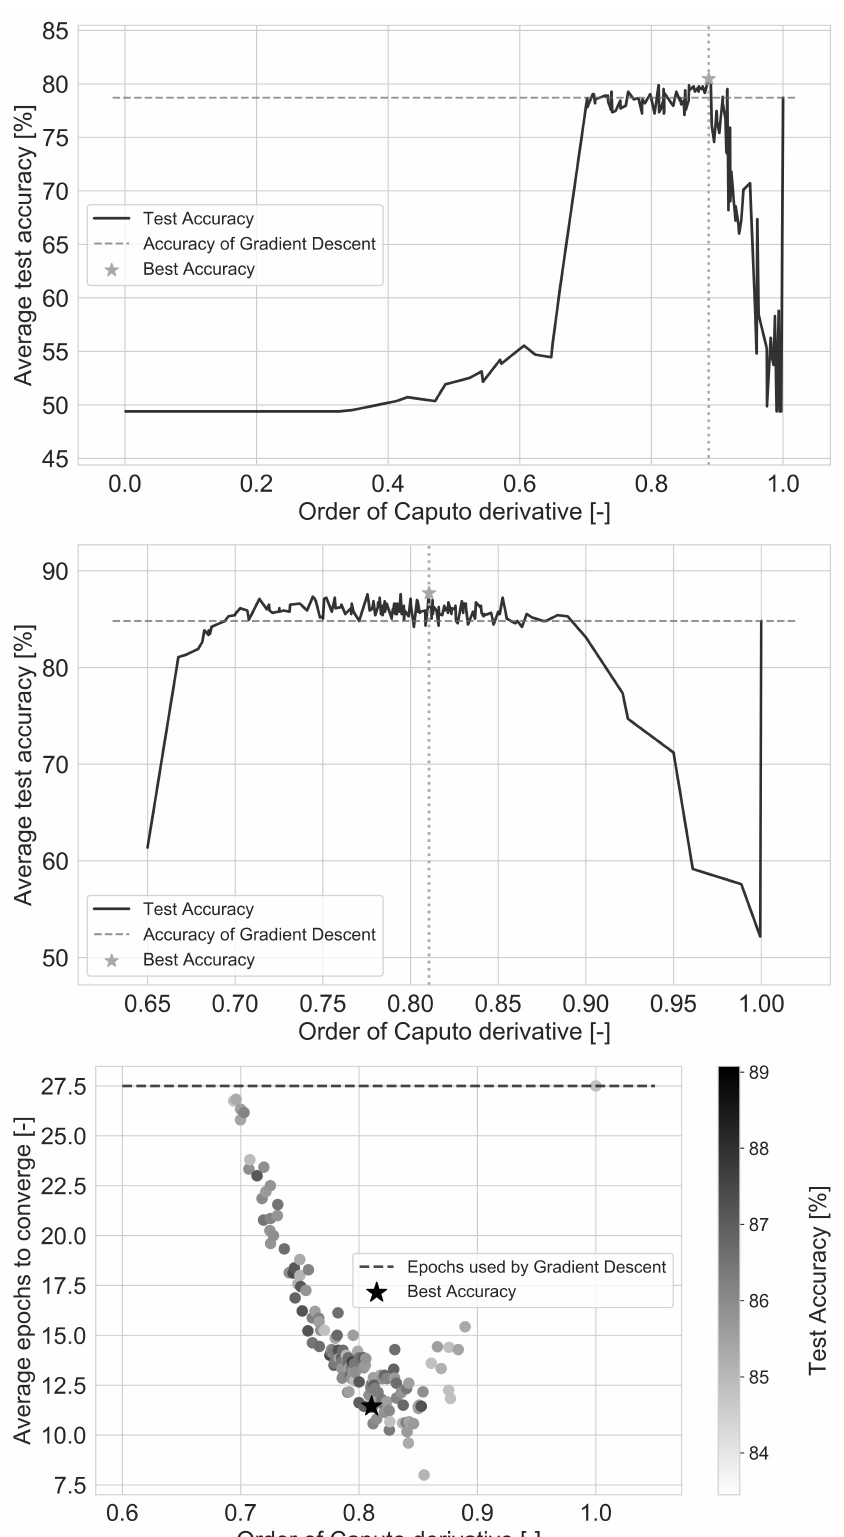
Figure 7. Average test accuracy of the two PSO runs, and the average training epochs taken to reach Gradient Descent’s accuracy for the second run (from top to bottom) on the Sonar